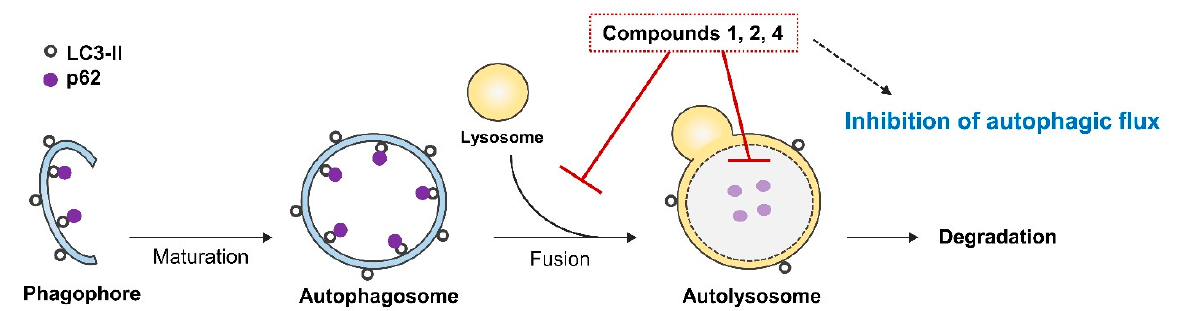
Figure 7. Illustration of the inhibition of autophagic flux by isolated compounds. Compounds 1 , 2 , and 4 exhibited the inhibition of autophagic flux, blocking the fusion of autophagosomes with lysosomes or inhibiting the autolysosomal protein-degradation process.